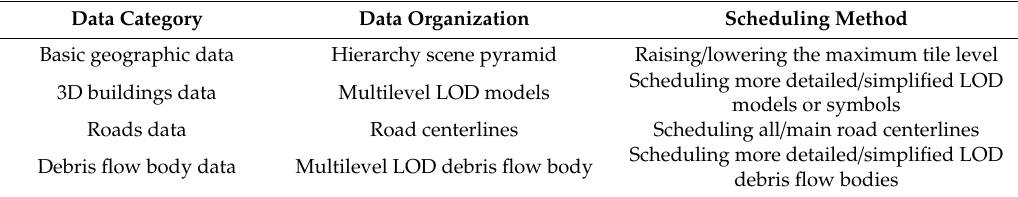
Table 1. Dynamic scheduling method of diverse debris flow scene data.